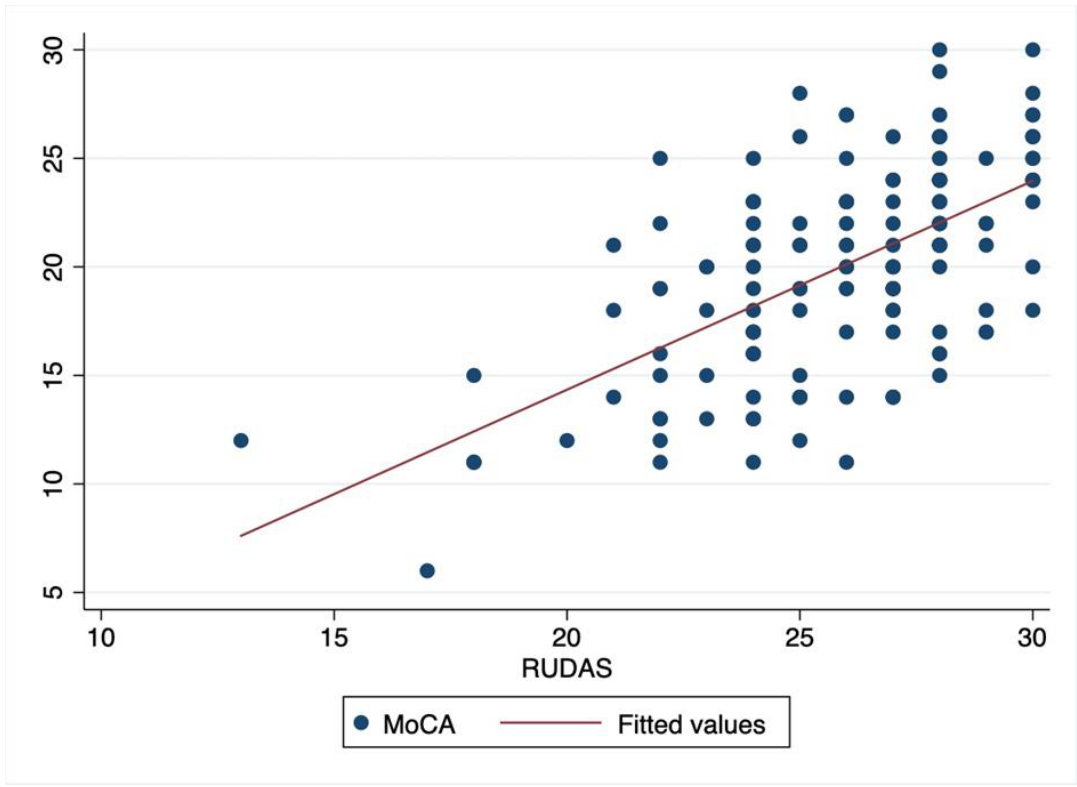
Figure 2. Scatter plot of correlation between RUDAS-Thai and MoCA-Thai.